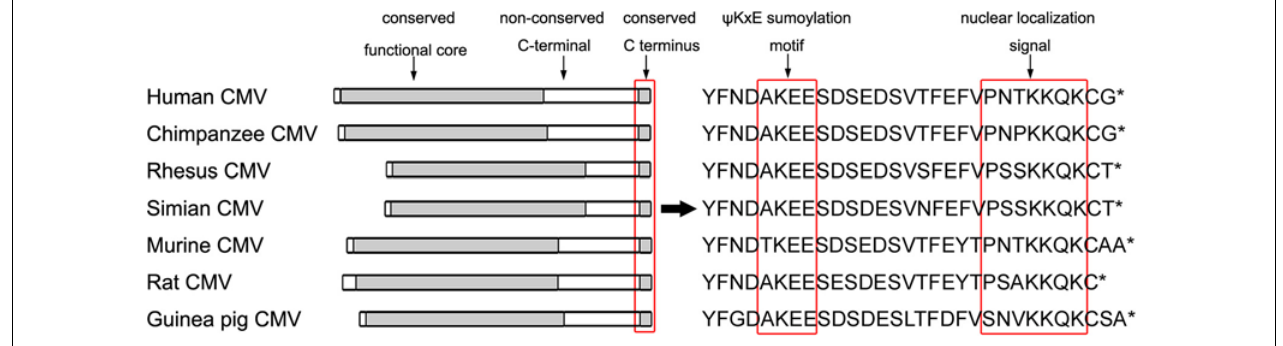
FIGURE 8 | UL44 homologs share a highly conserved C terminus. Nuclear localization signals are indicated by red box. Putative ψ KxE consensus sumoylation motifs corresponding to HCMV 410 lysine are indicated in boldface type and by red box. The single-letter amino acid code is used and * means the end of a